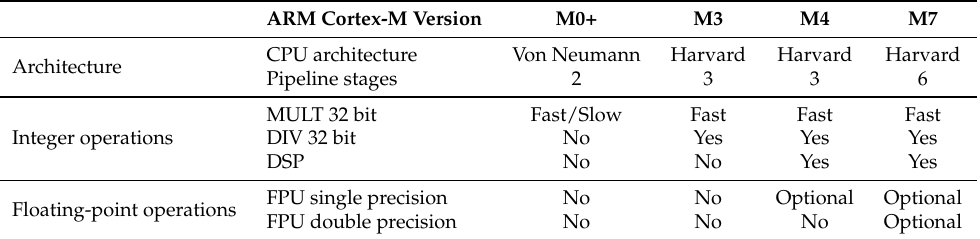
Table 1. Overview of various ARM Cortex-M features useful for computational